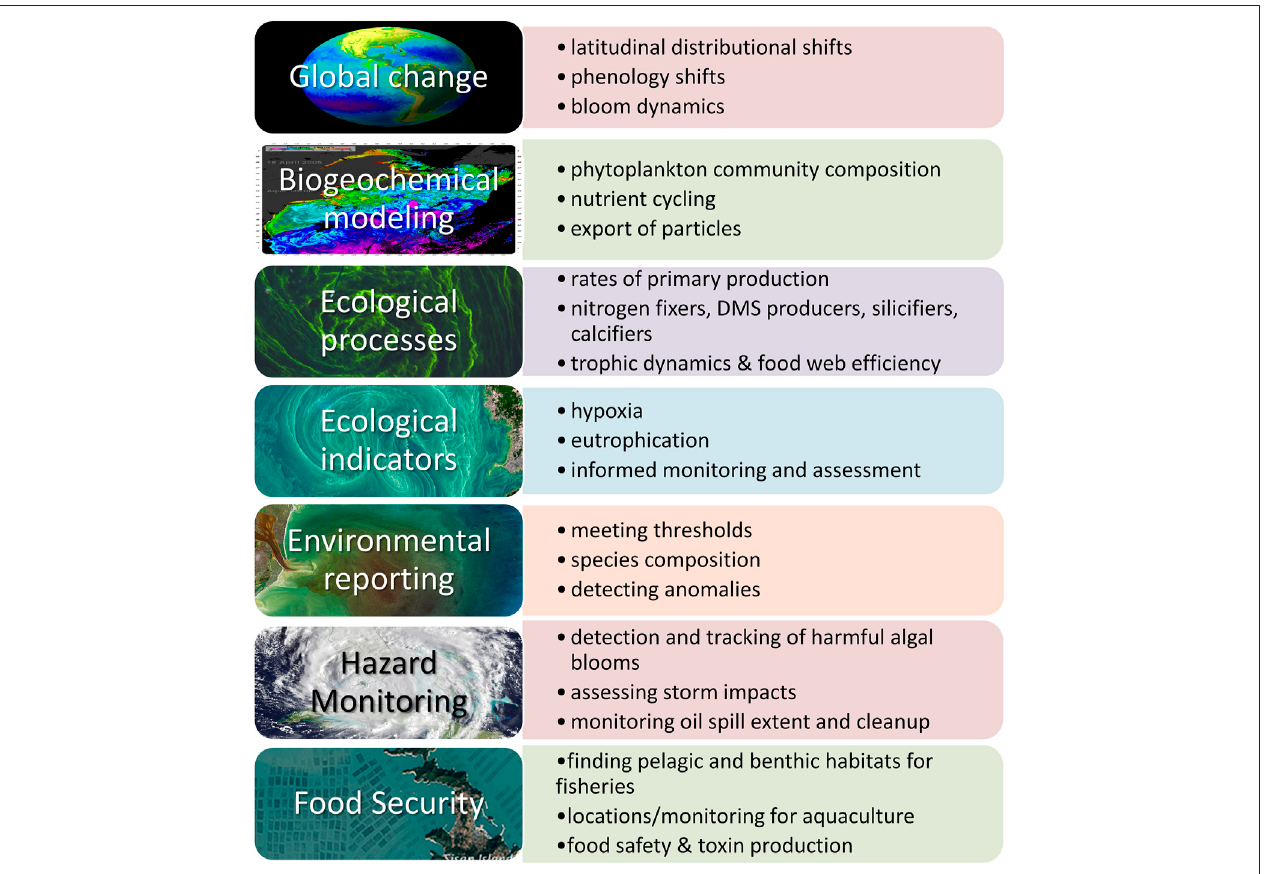
FIGURE 7 | A host of new applications will be available with better discrimination of pelagic and benthic biodiversity promised by hyperspectral imagery. Modi fi ed from Dierssen et al. (2020).